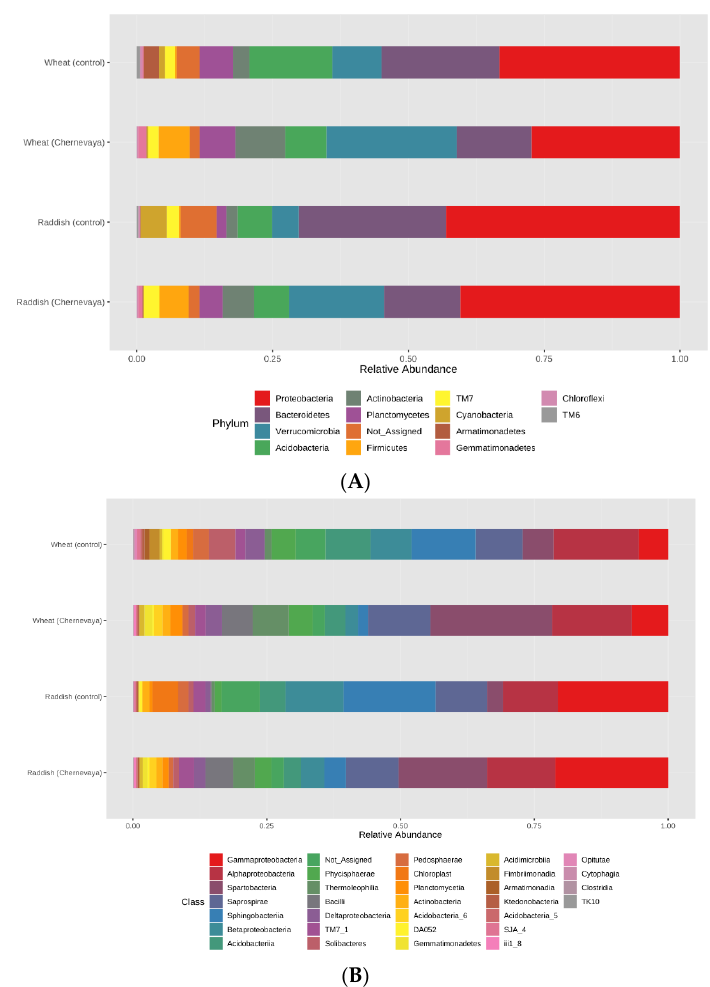
Figure 4. Relative average abundances of the prokaryotic taxa in the rhizosphere of radish and wheat, growing on the T1 and T3 soils in the laboratory experiment on the phyla ( A ) and classes ( B ) level. The values were summarized at phylum level (keeping only phyla with relative abundance >1%) and relativized to 100%. See Supplementary Table S1 for the abundance values for each tax- onomic level.